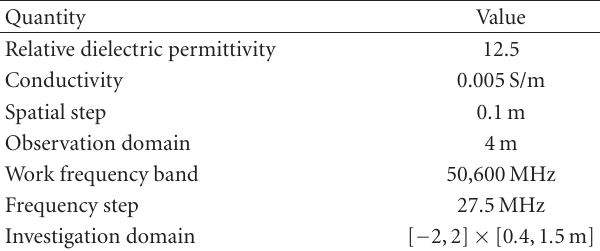
Table 1: Parameters adopted in the inversion scheme.